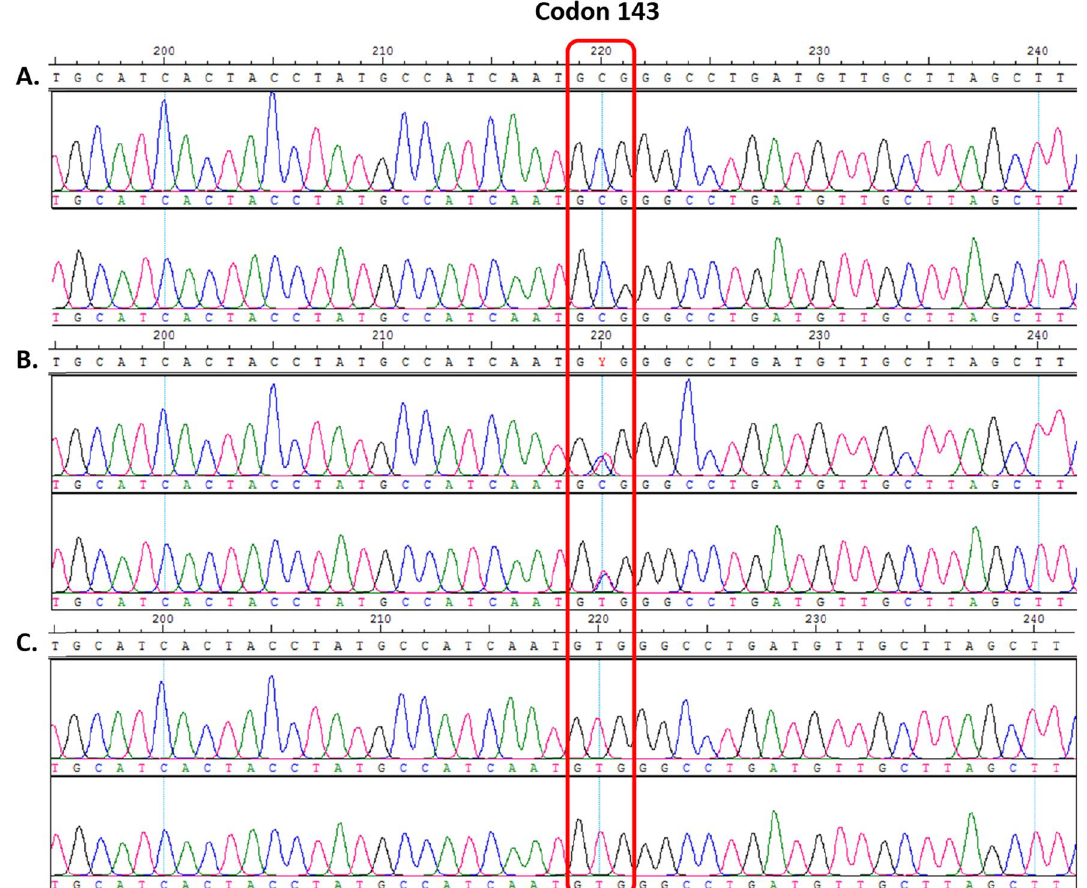
Figure 2. DNA nucleotide bases are each highlighted with a different colour. Electropherogram profiles of three different Rattus rattus complex samples depicting wild type (A) , heterozygous (B) and homozygous (C) SNP mutations at codon 143 of exon 3.